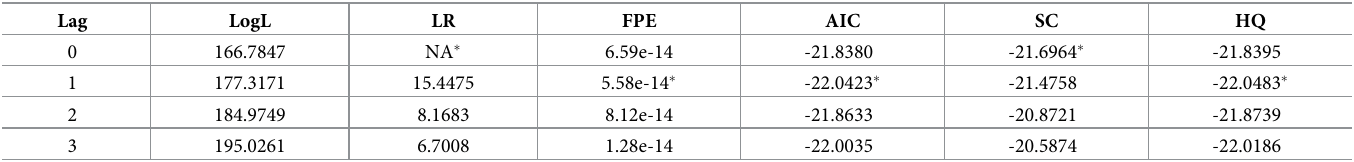
Table 4. Results of the lagged order test at the world level.